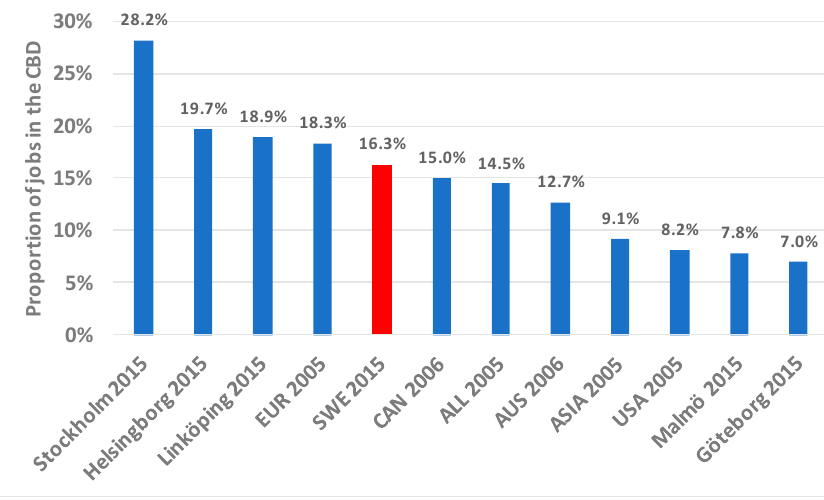
Figure 3. Proportion of jobs in the CBD in five Swedish cities (2015) compared to a sample of global cities (2005–2006).